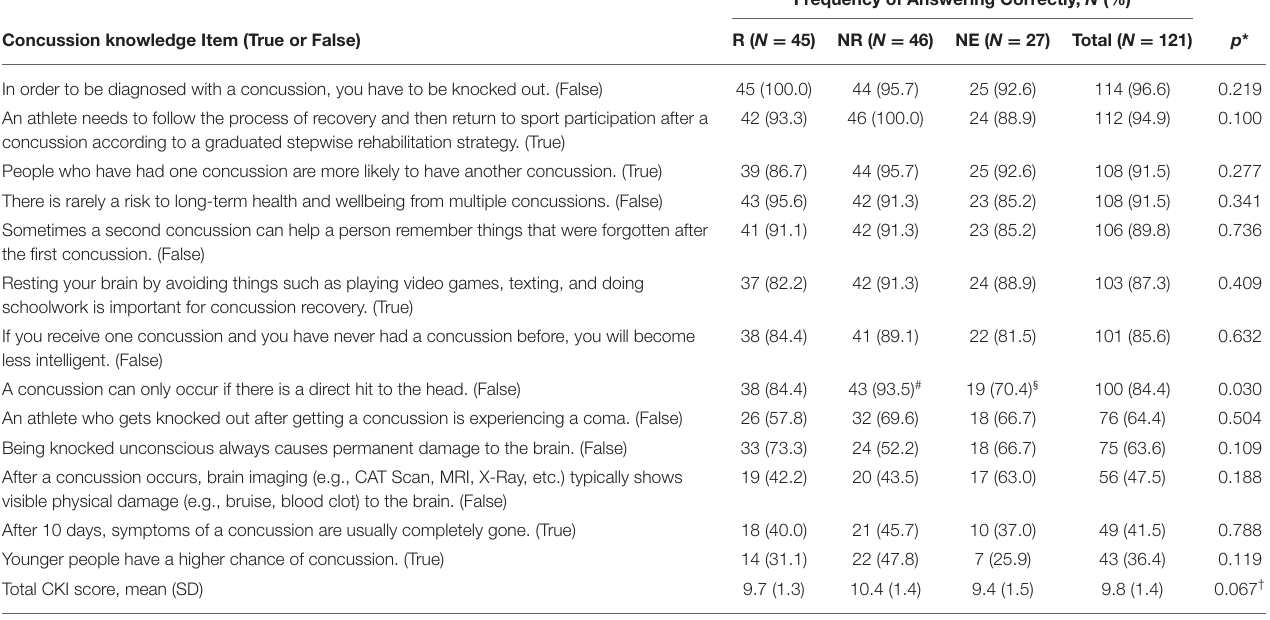
Frequency of Answering Correctly, N